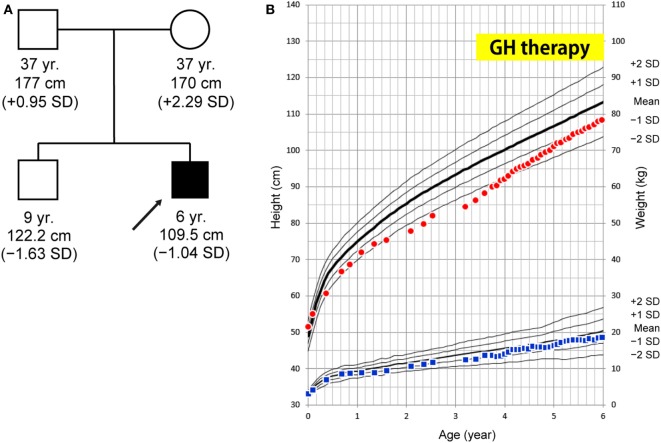
(A) Family tree. (B) Growth curve. At age 38 months, the patient’s height was 84.5 cm (−2.89 SD) and growth hormone (GH) therapy was commenced. The patient’s growth curve significantly improved with GH treatment over time. Height curve; red circles, weight curve; blue squares.